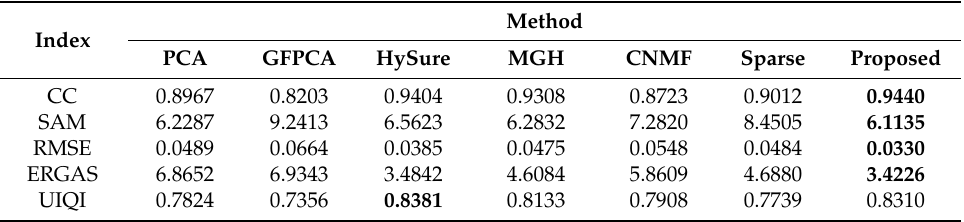
Table 2. Quality metrics of different methods for Pavia University